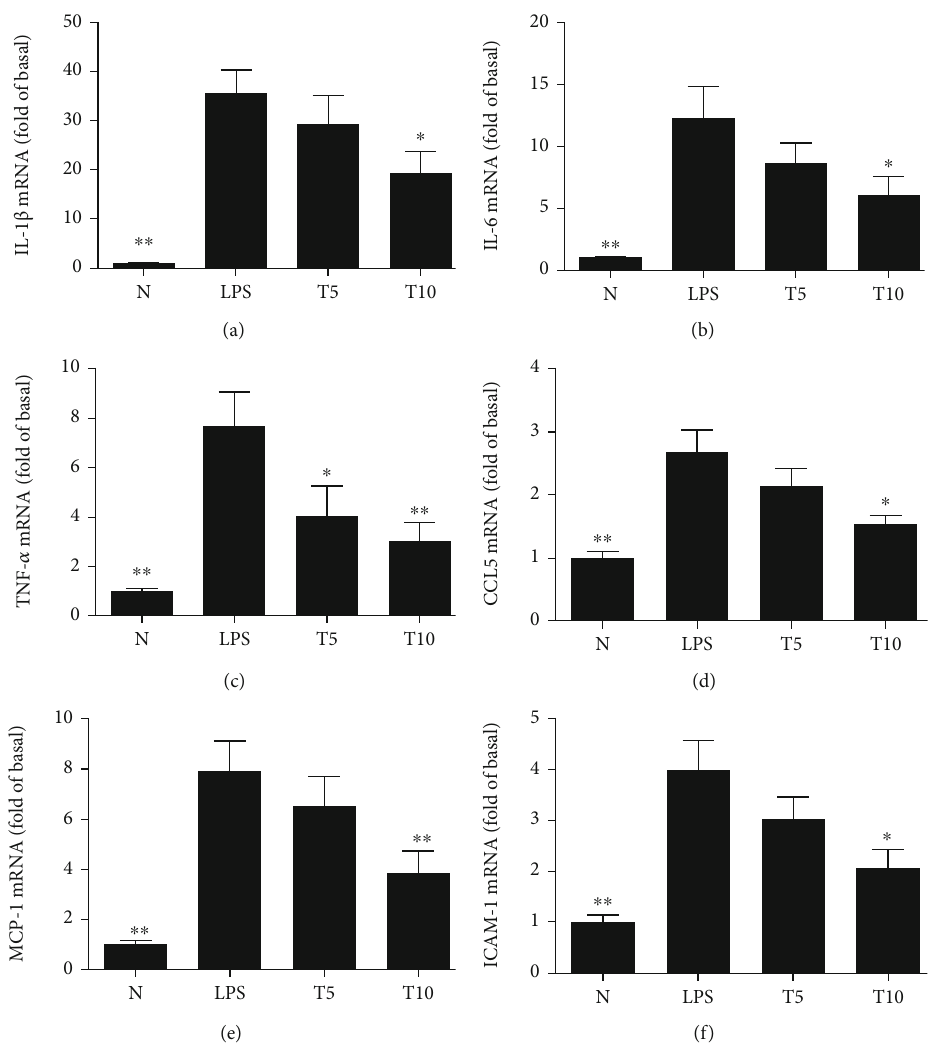
Figure 4: Tomatidine modulated gene expression in lung tissue. (a) IL-1 β , (b) IL-6, (c) TNF- α , (d) CCL5, (e) MCP-1, and (f) ICAM-1. Fold expression is shown relative to β -actin expression. Data are presented as the mean ± SEM . ∗ p < 0 : 05 and ∗∗ p < 0 : 01 vs. LPS group. N group: normal control mice; LPS group: LPS treatment only; T5 group: 5mg/kg tomatidine plus LPS; T10 group: 10 mg/kg tomatidine plus